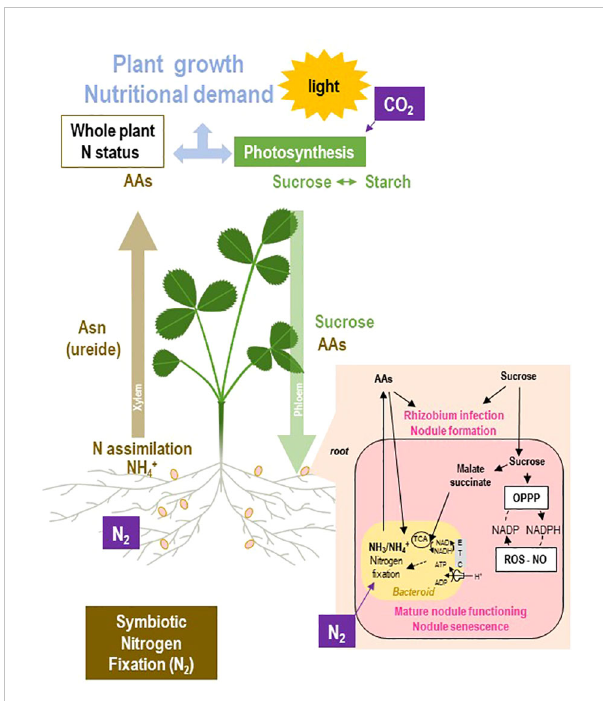
FIGURE 2 Overview of the N and C fl uxes within the rhizobium – legume holobiont using symbiotic nitrogen fi xation as the sole source of nitrogen. Atmospheric N 2 is fi xed into NH 3 /NH 4+ by nitrogenase in the bacteroids of the root nodule. The resulting NH 4+ is delivered to the plant cells where it is assimilated into amino acids (AAs). In temperate legumes, asparagine (Asn) is the main form of transport of nitrogen from the root to the shoot through the xylem fl ux, whereas in some tropical legumes, this transport involves ureides. Photosynthesis allows the plant to capture light and CO 2 to produce sugars that are either distributed as sucrose within the plant through the phloem to the “ sink ” organs or stored as starch. Sucrose is delivered to the roots together with AAs enabling nodule development and symbiotic activity. Nitrogen fi xation is energy costly and requires intense fueling by the plant to the symbiont. Malate and succinate are the main sources of carbon and energy provided by the plant to the bacteroid, where they are used through the tricarboxylic acid (TCA) cycle to generate reducing power and ATP. Despite the fact that nitrogen fi xation produces large amounts of NH 4+ , the assimilation of NH 4+ is repressed in bacteroids, and therefore amino acids are acquired by the bacteroid from the plant. Nodule sucrose also fuels the oxidative pentose phosphate pathway (OPPP) regenerating the reducing power required to maintain redox homeostasis under the microoxic conditions of nodules. The plant growth determines the N and C nutritional requirements of the plant. ETC, electron transfer chain; NO, nitric oxide; ROS, reactive oxygen